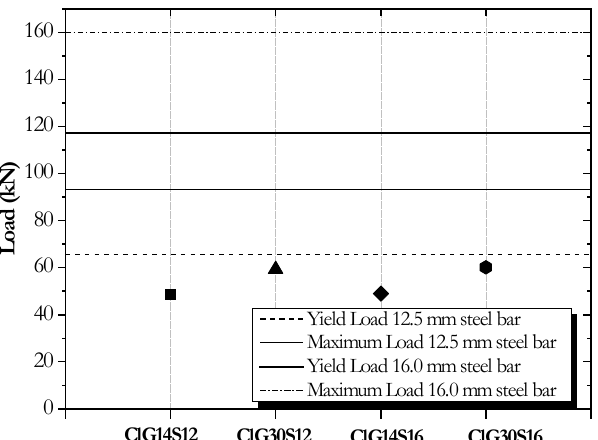
Figure 3. Results of the pull-out of clay block specimens with yield load and maximum load of the reinforcements [11].